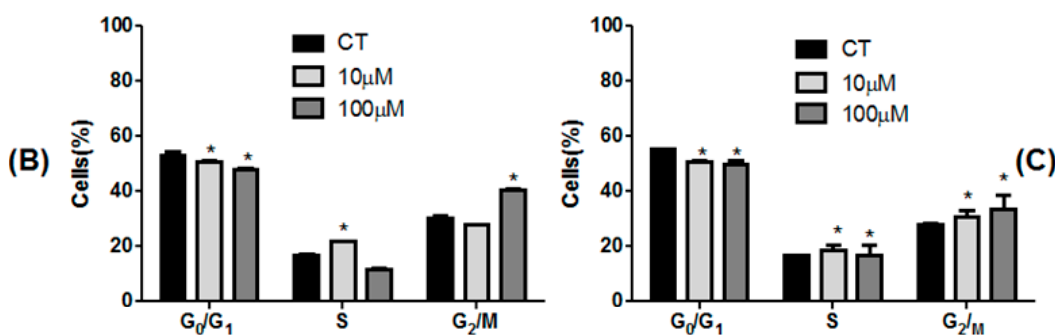
Figure 4. Effect of FA and VA on cell cycle progression in HT-29 cells 24 h after incubation. The phases of the cell cycle are illustrated at control (CT) and treated with 10 µ M and 100 µ M of these compounds in figure ( A ). The quantitative results of the effect of FA compound on this cell line are shown in figure ( B ) and VA in figure ( C ). The experiment is expressed as mean ± SD. Significant differences between untreated and treated (10 µ M and 100 µ M) cells were compared by the One-way ANOVA test, with Tukey posttest (* p < 0.05).